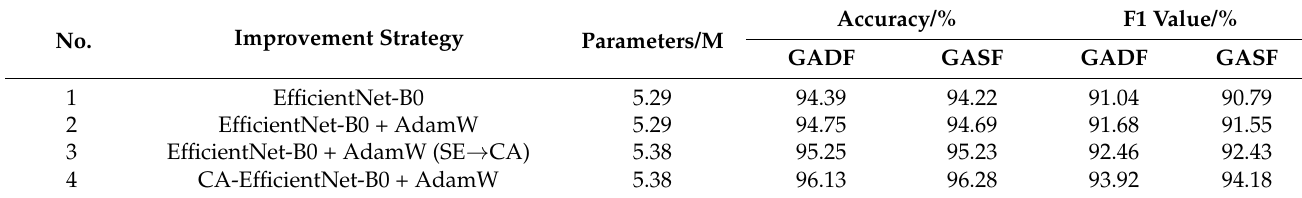
Table 4. Ablation study results for CA-EfficientNet model.